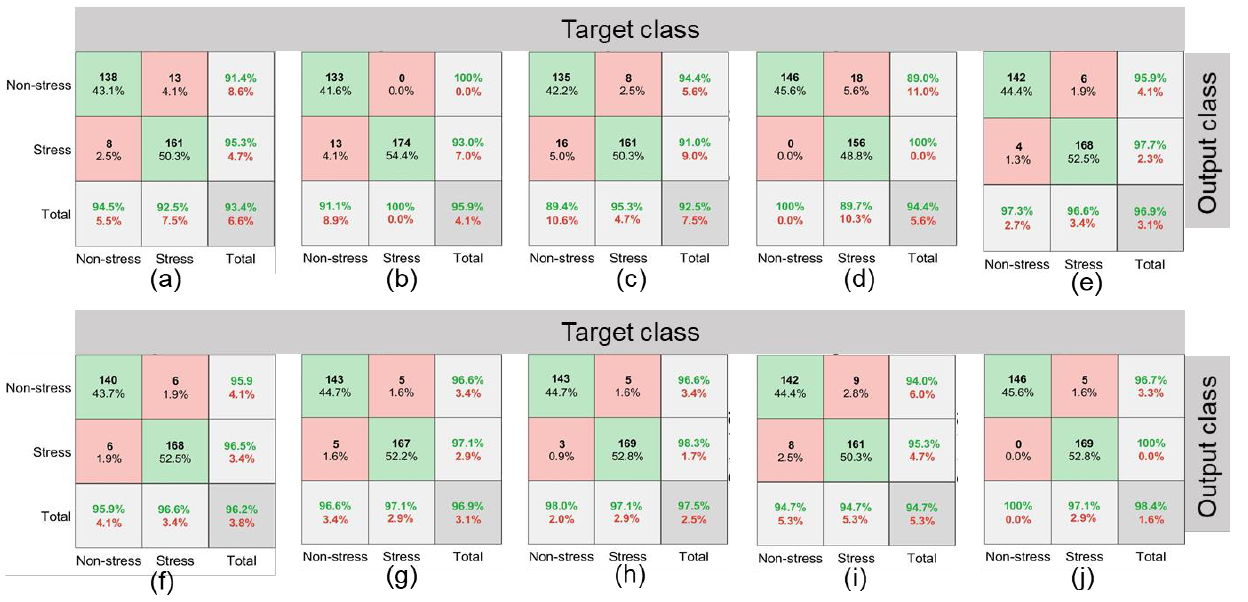
Figure 7. Confusion matrices for AlexNet, GoogLeNet, Inception V3, MobileNet V2, and ResNet50 models pertinent validation datasets of RGB imagery ( a – e ) and thermal imagery ( f – j ). Cell values (%) in row 1 column 2 represent type 1 error (T E1 ) while those in row 2 column 1 represent type 2 error (T E2 ) (details in Section 2.4). Numbers (% and actual counts) in green color indicate prediction accuracy while those in red color are prediction errors for stressed and non-stressed crop classes. Numbers in green box represent correct prediction and those in red box represent misclassification of non-stressed/stressed classes.